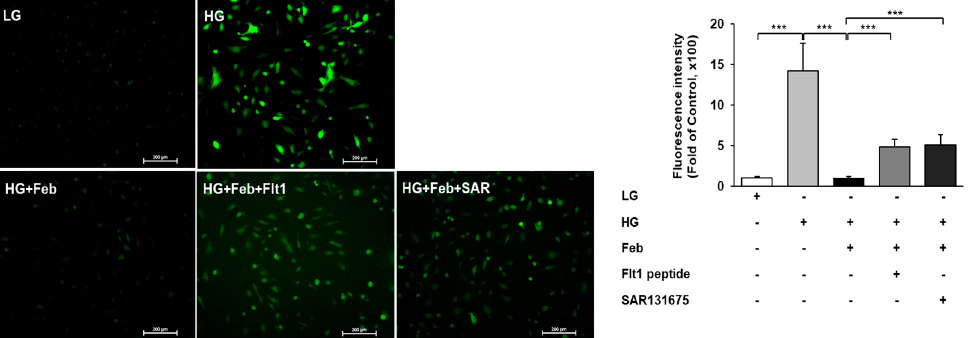
Figure 8. Representative image and quantitative analysis of ROS generation measured by DCF-DA assay according to VEGFR1 or VEGFR3 inhibition in HG-treated human GECs with or without febuxostat. *** p < 0.001.